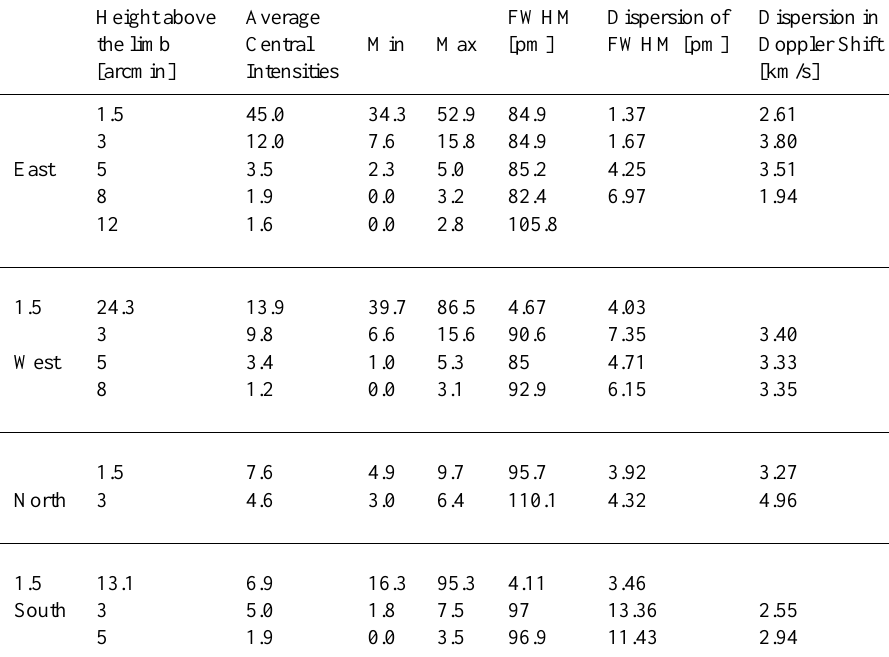
Table 2. Average for each slit length of the measured parameters of FeXIV line emissions in different locations of the solar corona (see Fig. 1). We did not report all the analysed data (see Table 1), in order to keep a good enough signal-to-noise ratio, which means that very low level emissions are not discussed here. Height above Average FWHM Dispersion of Dispersion in the limb Central Min Max [pm] FWHM